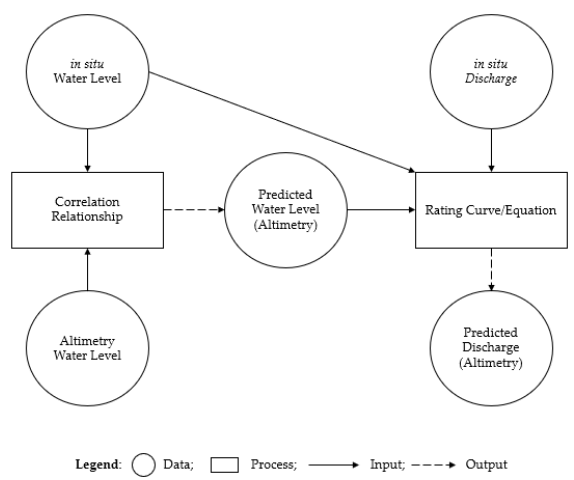
Figure 2. Methodology for estimating missing discharge data using radar altimetry, in situ water level, and rating curve/equation.